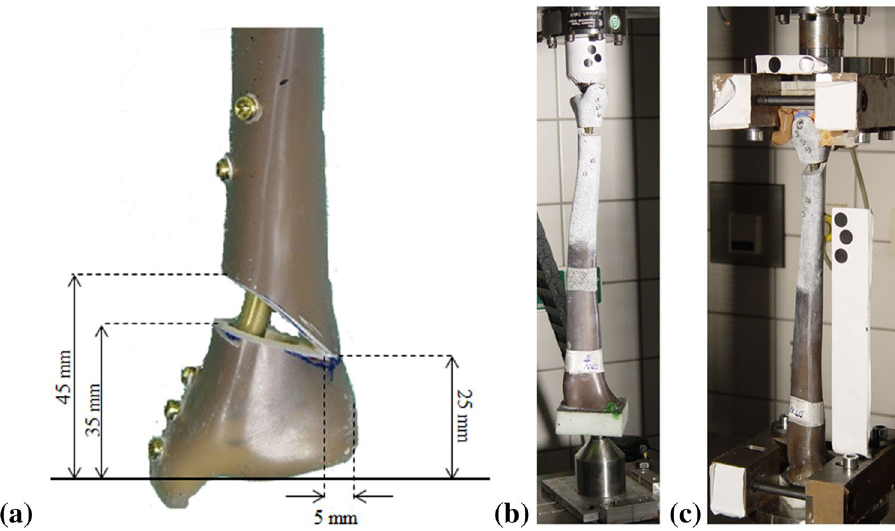
Figure 1. Planned measurements for the medial wedge osteotomy simulation used in this study ( a ), and test setups for compressive ( b ) and torsional ( c )